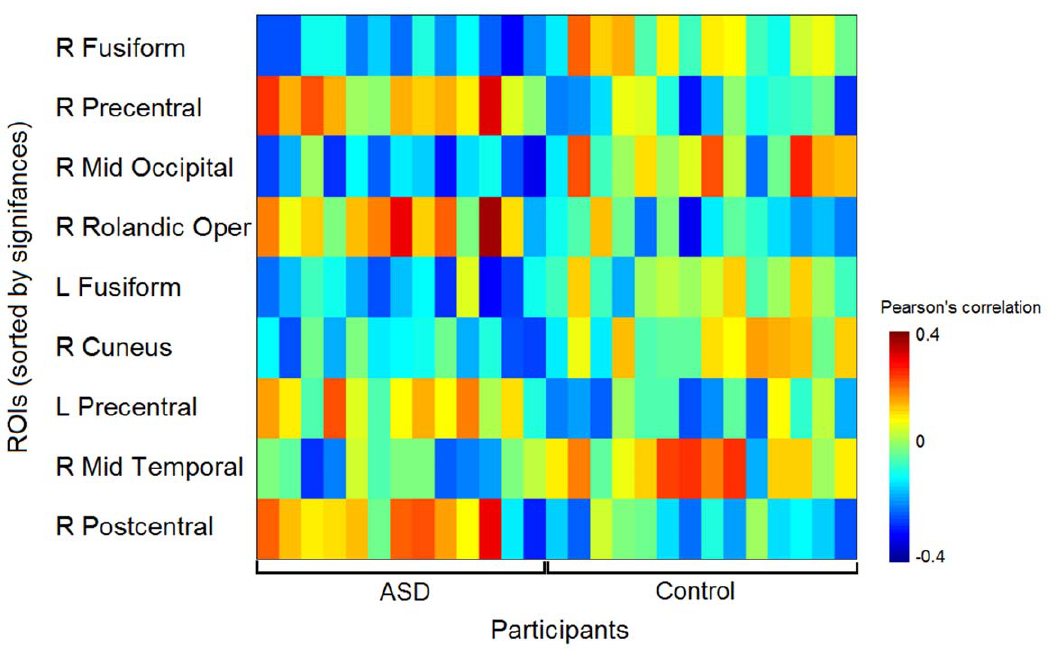
Figure 4. Correlations of resting-state time courses in which classification was based between ROI and seed region in the left AG, that showed significant group difference ( p =0.05, with Bonferroni correction), for each of the